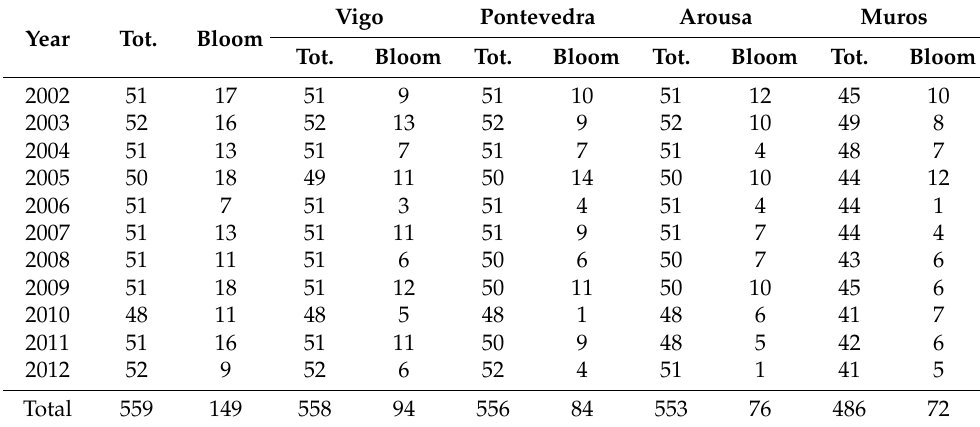
Table 4. Sampling effort (Tot.) and bloom incidence (Bloom) for each ria and year.